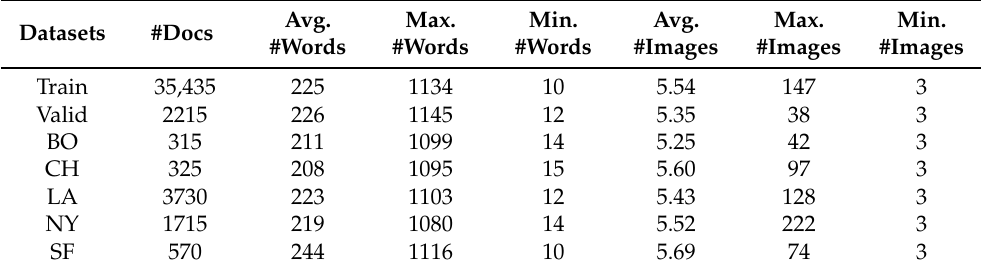
Table 1. Statistics of the Yelp